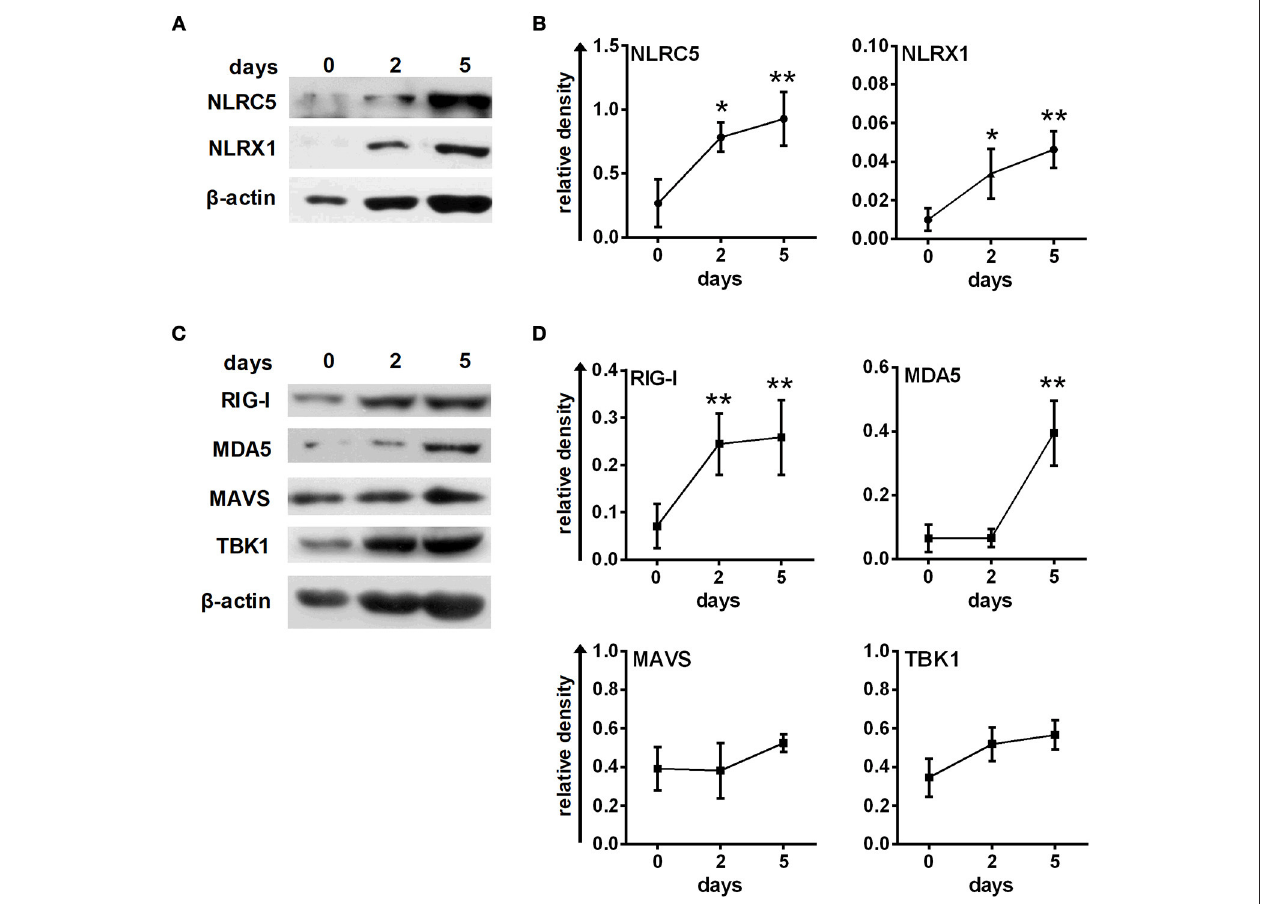
FIGURE 5 | Human immature moDCs constantly express NLRC5, NLRX1, RIG-I and MDA5. (A–D) Freshly isolated monocytes were seeded in 24-well plates and differentiated as described in the “Materials and Methods.” The protein levels of NLRC5, NLRX1, RIG-I, MDA5, MAVS, and TBK1 were measured by western blot. (A,C) Representative blots are shown. (B,D) Graphs represent the kinetics of protein expressions during moDC differentiation. Data are represented as mean ± SD of 3–5 individual experiments and were analyzed using one-way ANOVA followed by Bonferroni’s post-hoc test. * p < 0.05, ** p < 0.01 vs. day 0.